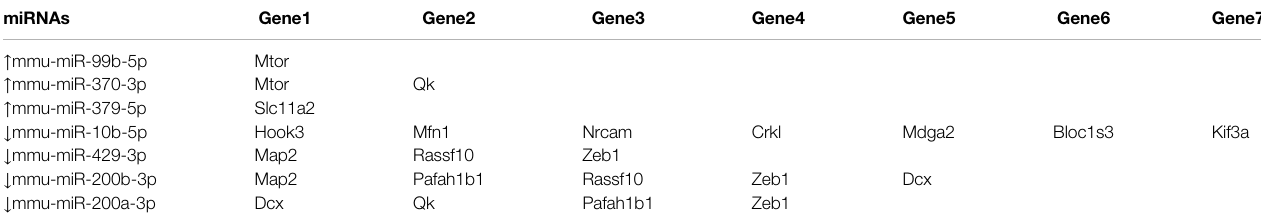
TABLE 4 | Predicted targets of selected neurogenesis-related DE miRNAs. miRNAs